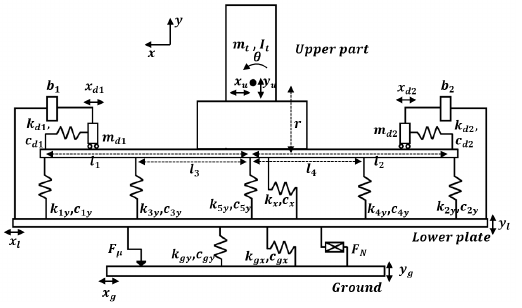
Figure 11. 7DOF model of the isolator system with two TMDs in the x direction combined with two inerters. Table 3. Chosen parameters for the TMDIs in different cases.